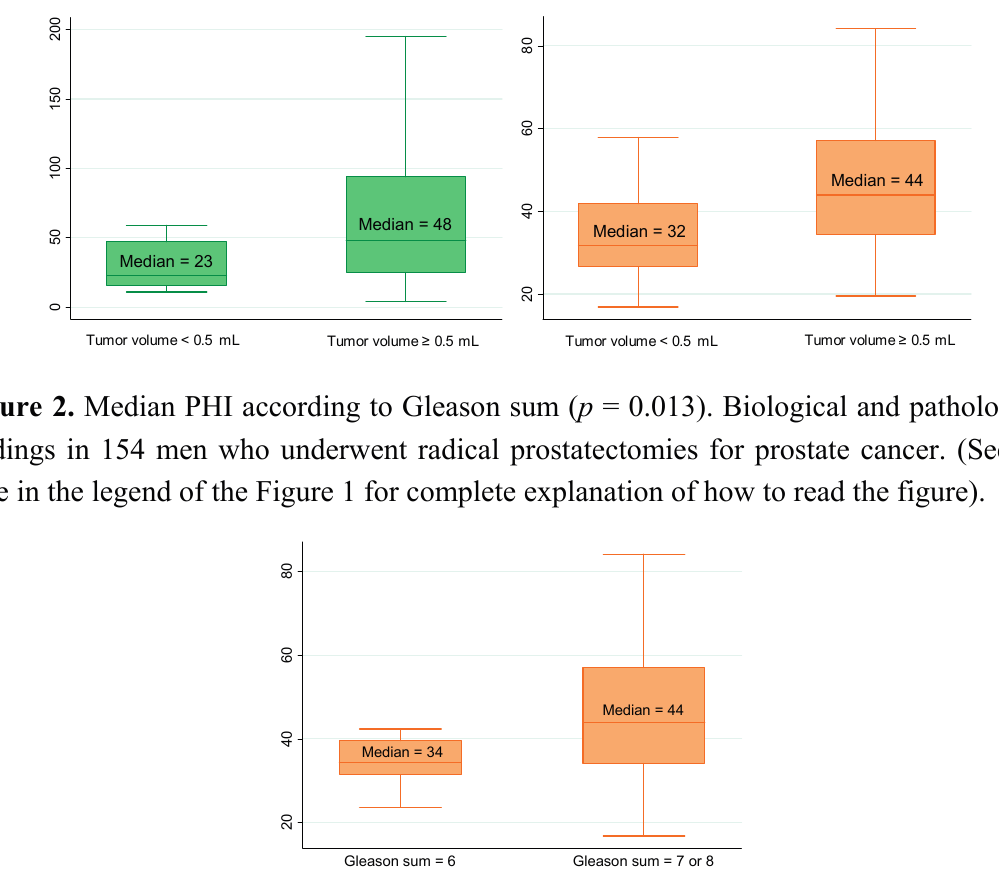
Figure 1. Median PCA3 score ( p = 0.004) and PHI ( p = 0.002) according to tumor volume. Biological and pathological findings in 154 men who underwent radical prostatectomies for prostate cancer. Note: The boxes are bordered at the 25th (p25) and the 75th (p75) percentiles (the so-called inter-quartile range IQR) with the median line at the 50th percentile. Whiskers extend from the box to the upper and lower adjacent values. The upper adjacent value is defined as the largest data point ≤ (p75 + 1.5 × IQR). The lower adjacent value is defined as the smallest data point ≥ (p25 − 1.5 × IQR).